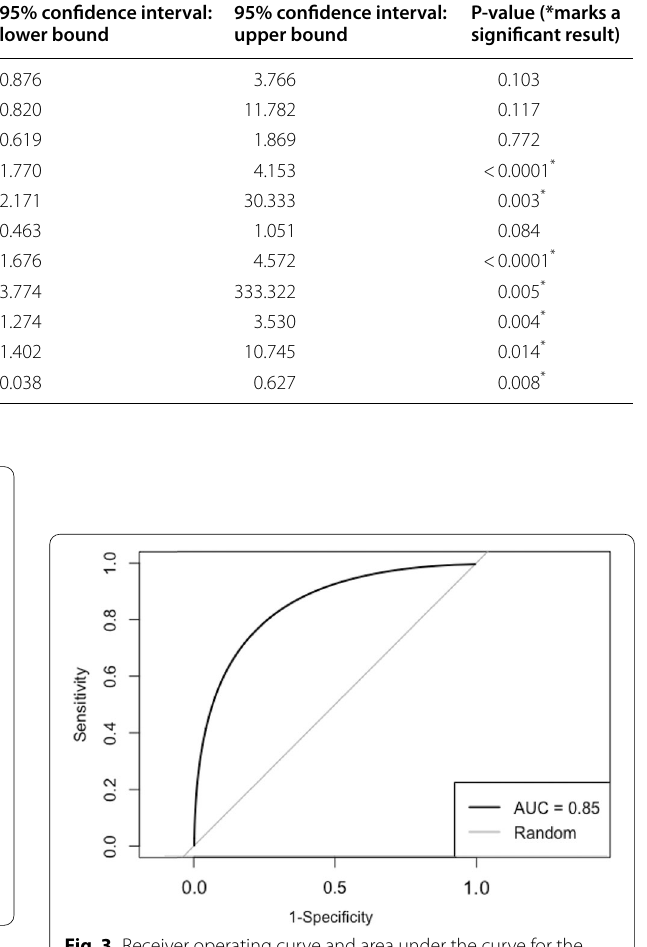
Fig. 3 Receiver operating curve and area under the curve for the CMDS with mortality in-hospital as the